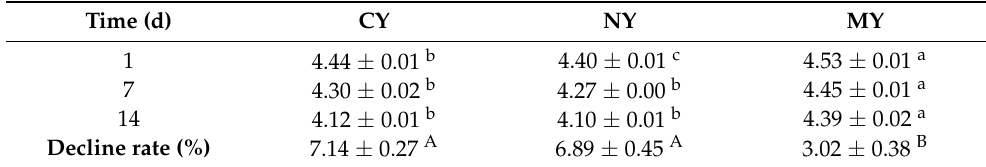
Figure 8. The whey precipitation of yogurt (A: CY, B: NY, C: MY). Table 4. Changes in yogurt pH value over time. Different superscript letters in the same row indicate significant difference ( n = 3, p < 0.05).